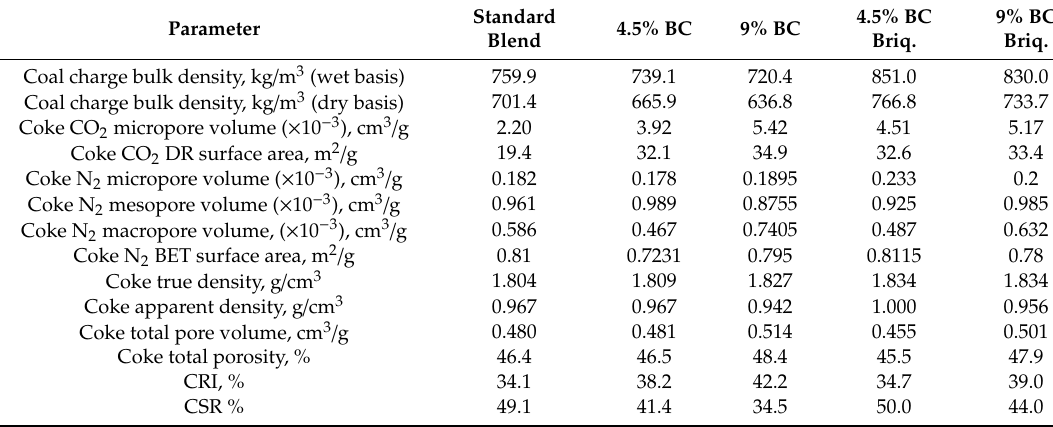
Table 2. Coal blend and coke